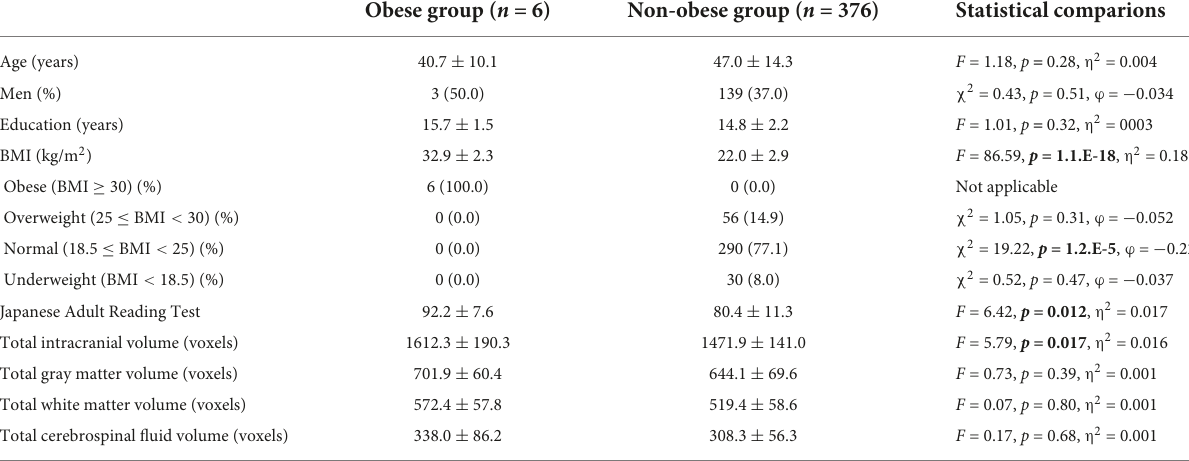
TABLE 3 Comparisons of variables between the obese and non-obese groups.